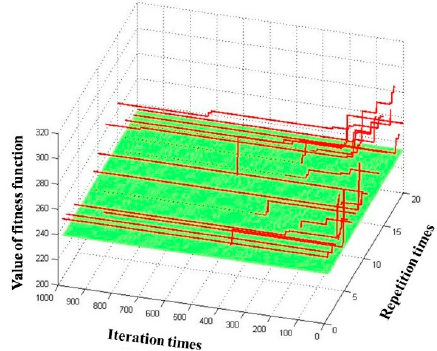
Figure 12. The detailed fitness function values of 1000 iterations with 20 repetitions of the modified ACO.